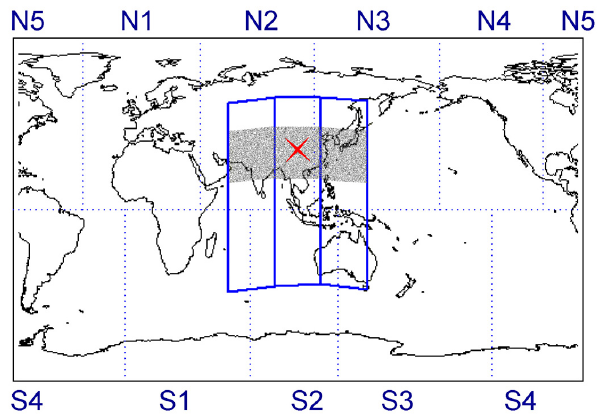
Fig. 3. Longitude sectors of a λ indices and western, Sichuan and eastern zones used for a statistical study. The epicentre is marked with a cross